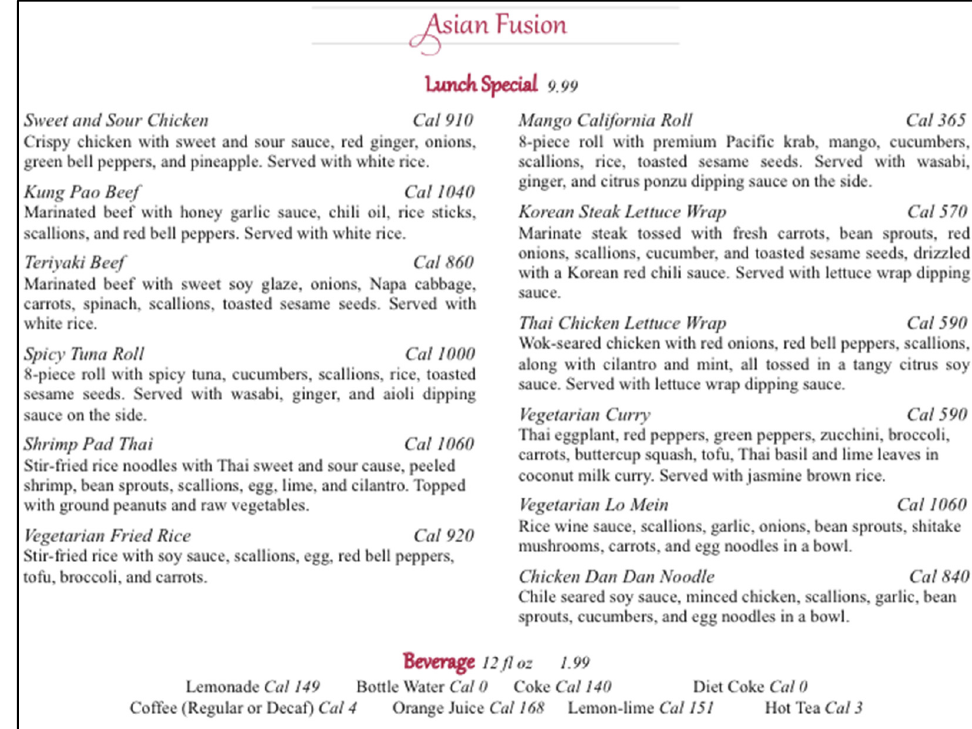
Figure A2. Asian Fusion First and Last Menu.